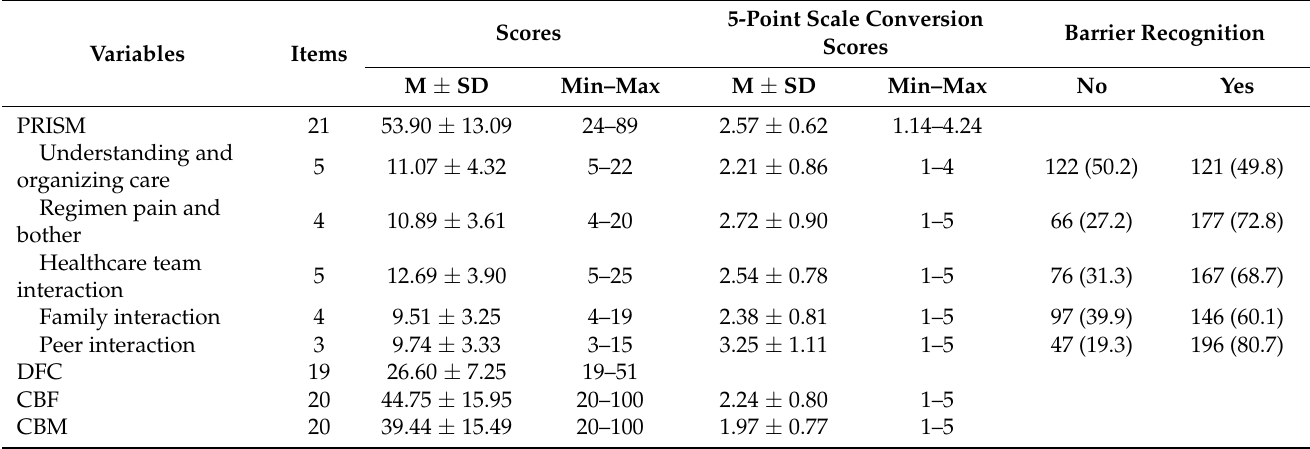
Table 2. Descriptive statistics of the examined variables ( n =